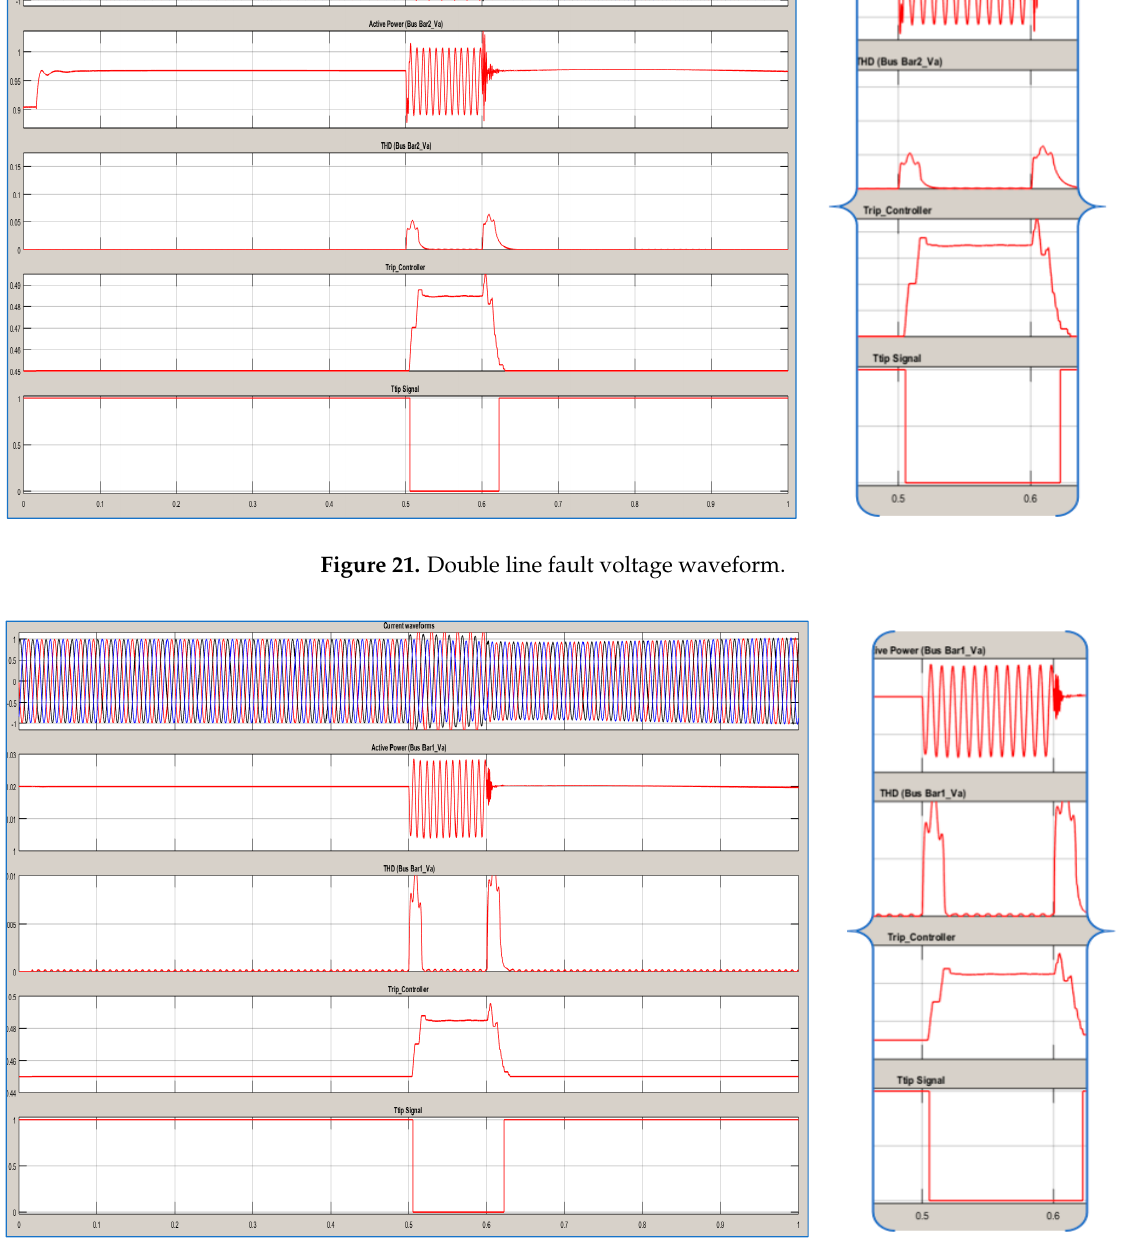
Figure 22. Double line fault current waveform.